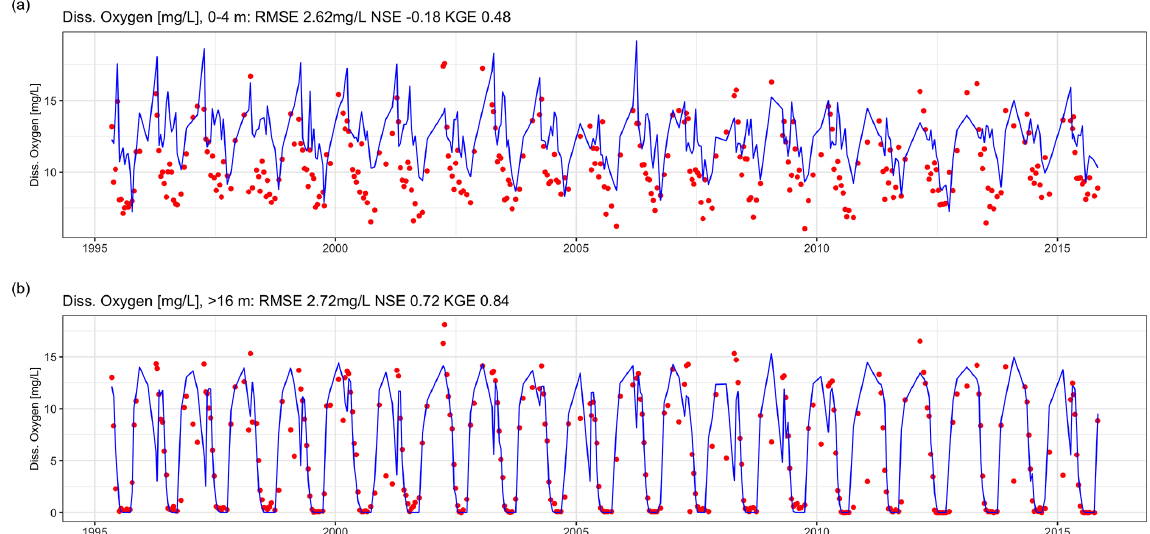
Figure 9. Time-series comparison between observed (red dots) and modeled dissolved oxygen concentrations (blue lines). The fit criteria were root mean square error (RMSE), Nash–Sutcliffe coefficient of efficiency (NSE), and Kling–Gupta coefficient of efficiency (KGE). (a) Averaged dissolved oxygen concentrations in the epilimnion (0–4m). (b) Averaged dissolved oxygen concentrations in the hypolimnion (deeper than